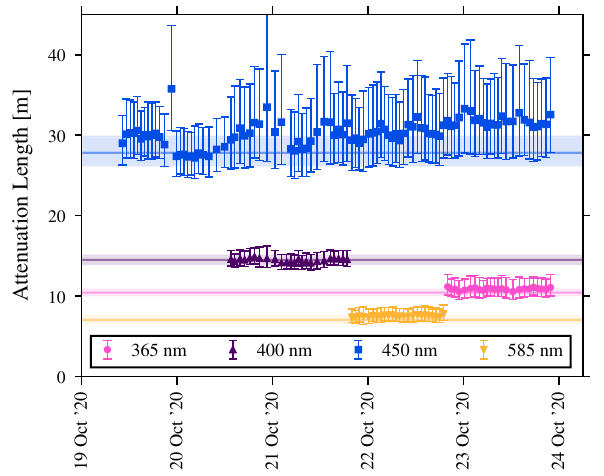
Fig. 5 Attenuationlengthfromajointmulti-wavelengthfitofallavail- able STRAW data. Measurements from the sites of other neutrino tele- scopes are plotted for comparison [11–13], as well as an estimate of the attenuation length in the clearest ocean waters [14]. The attenuation length at Lake Baikal has been measured using the neutrino detec- tor itself and an external flasher as a light source. The measurements denoted KM3NeT have been conducted in the Mediterranean sea with a WETLabs AC9 trasmissometer (green data points) and the Long Arm